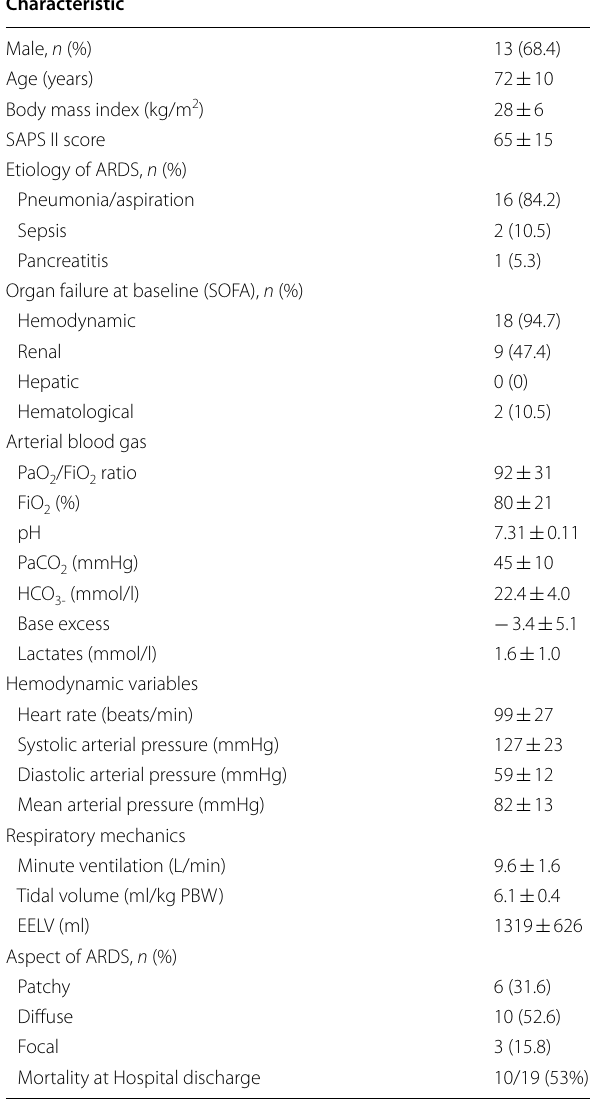
Table 1 Baseline characteristics of the patients ( n